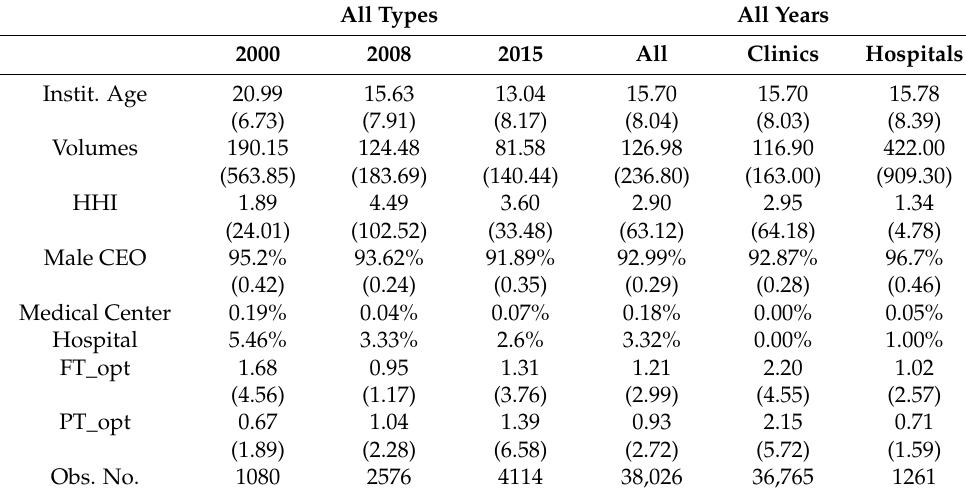
Table 2. Summary Statistics for Vision Care Facilities.